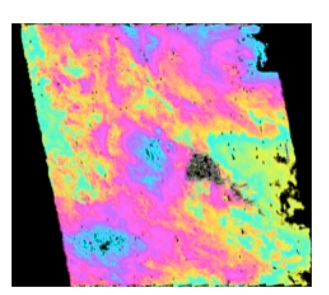
Figure 6. Browse of unwrapped interferogram.